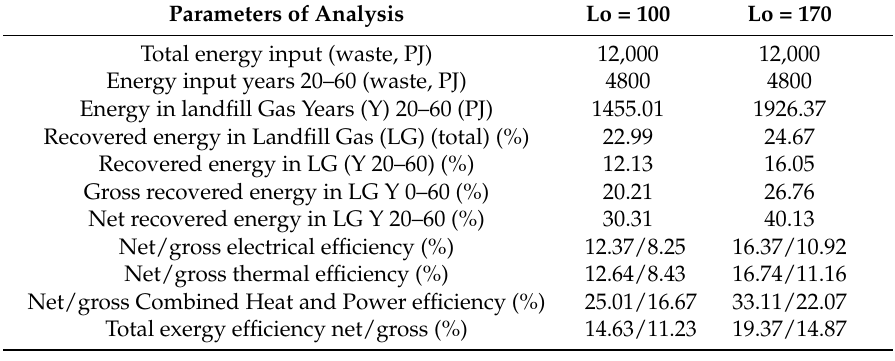
Table 2. Results from the energy recovery of landfill gas, as returned by the model LandGEM.